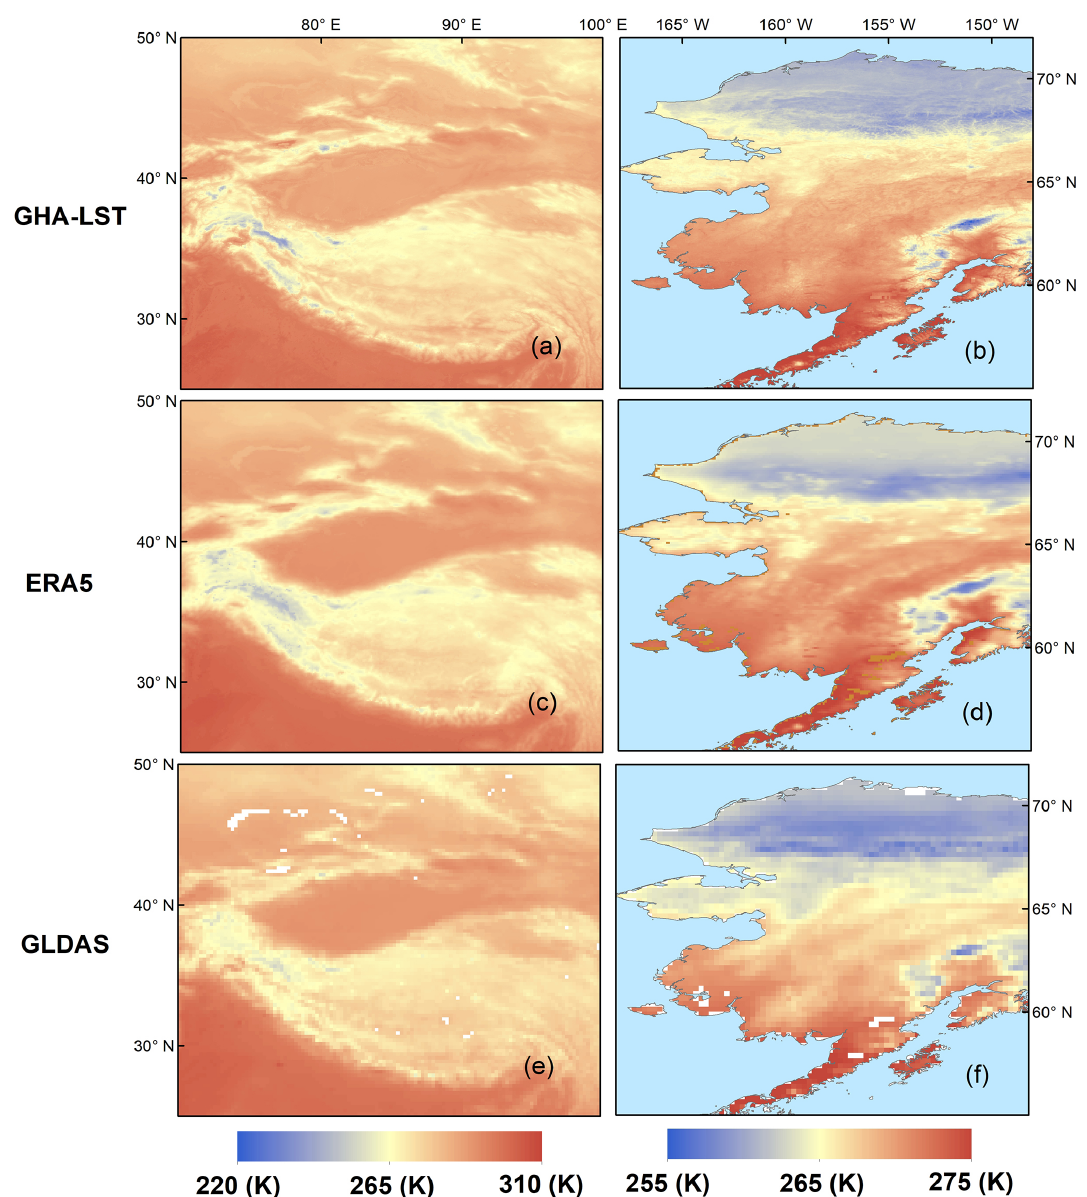
Figure 9. Temporally averaged all-sky LST maps in 2021 from (a, b) GHA-LST, (c, d) ERA5, and (e, f) GLDAS (a, c, e) over the Tibetan Plateau and (b, d, f) Alaska. The abbreviations used in the figure are as follows: GHA-LST – global hourly, 5km, all-sky land surface temperature and GLDAS – Global Land Data Assimilation